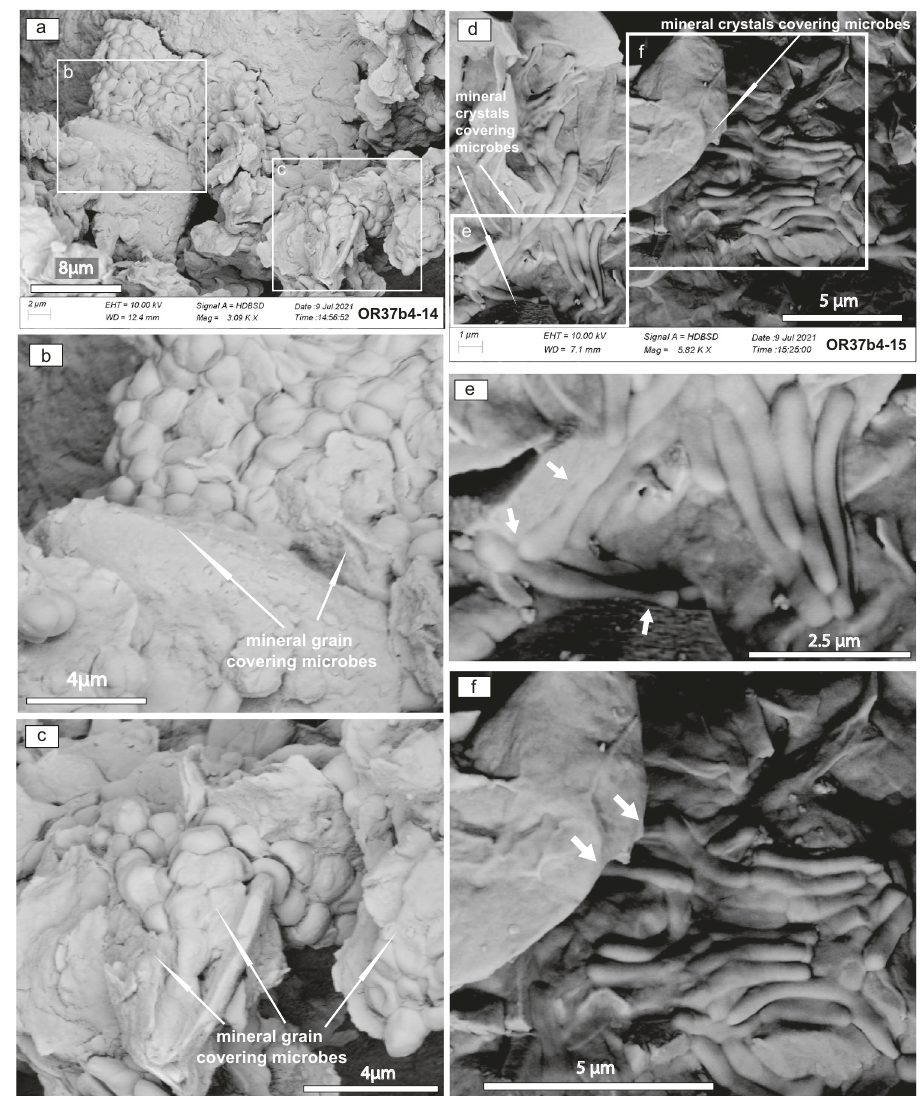
Fig. 8 | Cretaceous permafrost microbiome. a Sample OR37b4-14 shows miner- alized fossil microorganisms gathered in a monolayer. The microbial cells are enveloped in sheaths and form a fi lm, which contains numerous oval cells